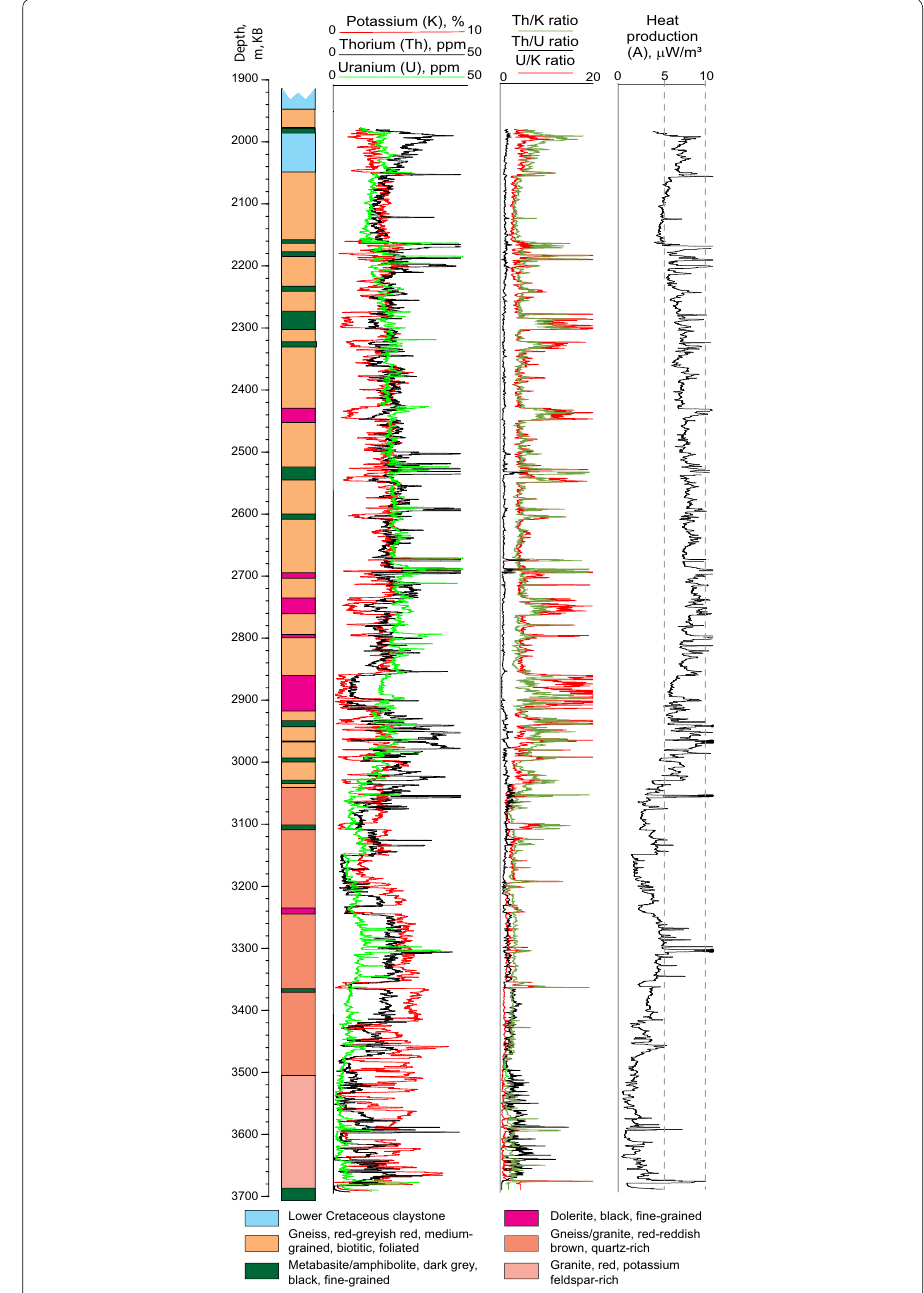
Fig. 7 Composite log of DGE‑1, showing lithology, spectral gamma ray logs, and calculated heat